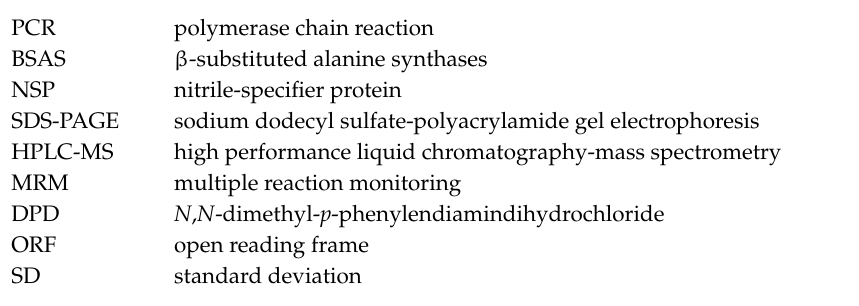
Table S1: Degenerate oligonucleotides and primers used for 3 (cid:48) - and 5 (cid:48) -RACE, cloning of full-length-cDNAs and generation of expression constructs, Figure S1: SDS-PAGE analysis of purified recombinant BSAS. Figure S2: β -Cyanoalanine formation by GrBSAS3, Figure S3: Kinetics of β -cyanoalanine synthases from